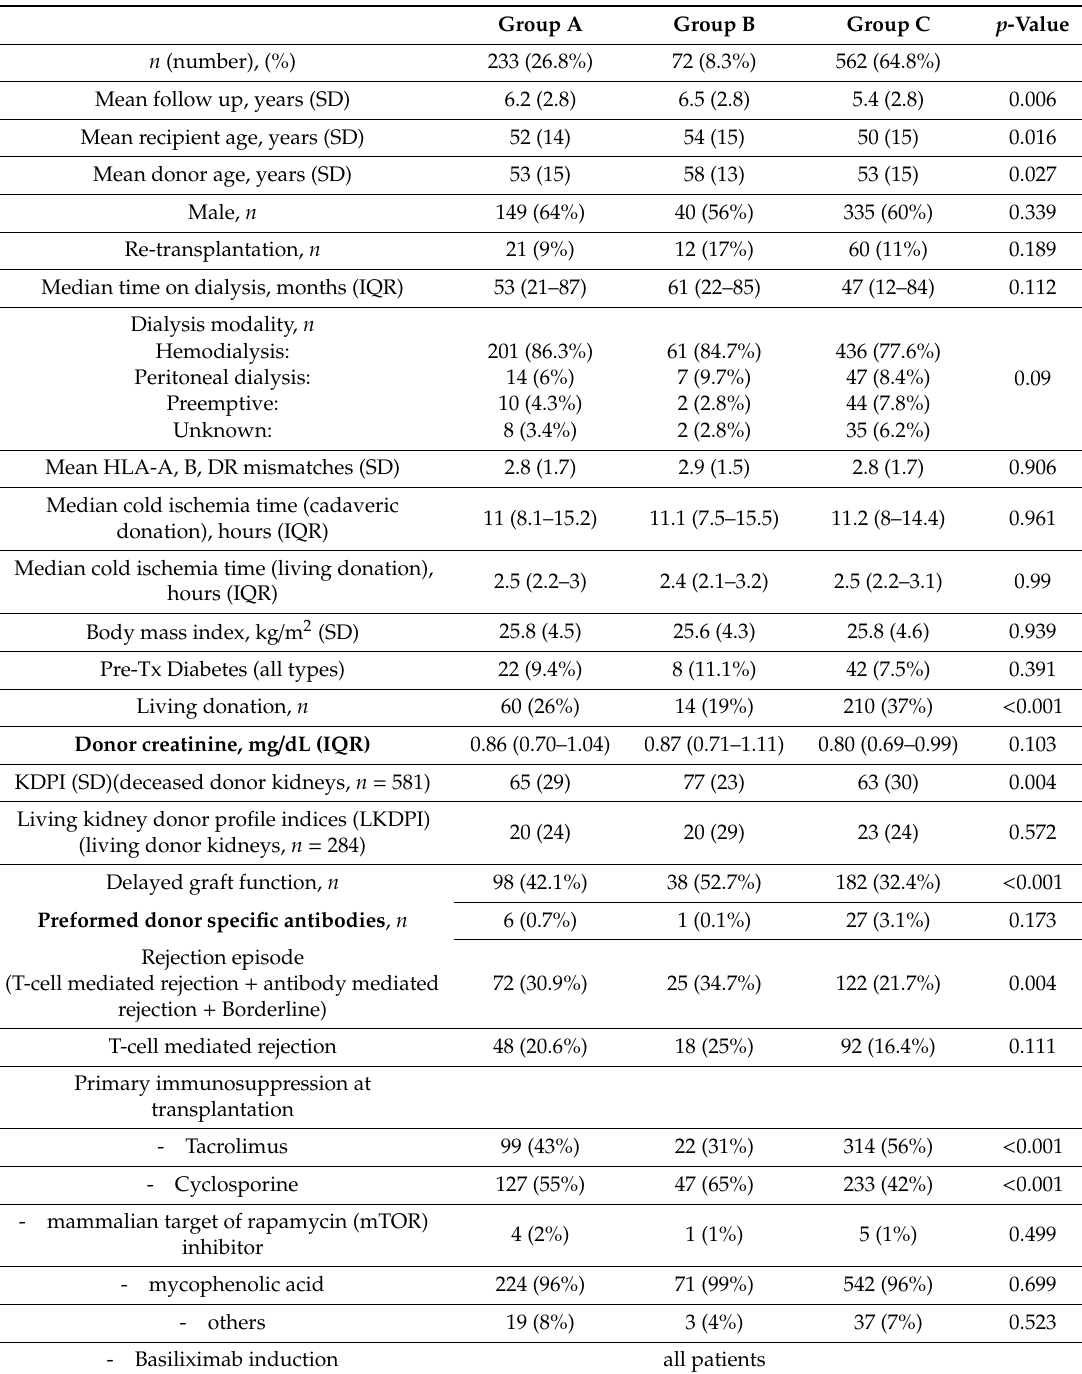
Table 1. Patient characteristics of subjects with conservatively monitored lymphoceles (group A), lymphocele treatment (group B) and of the control group (group